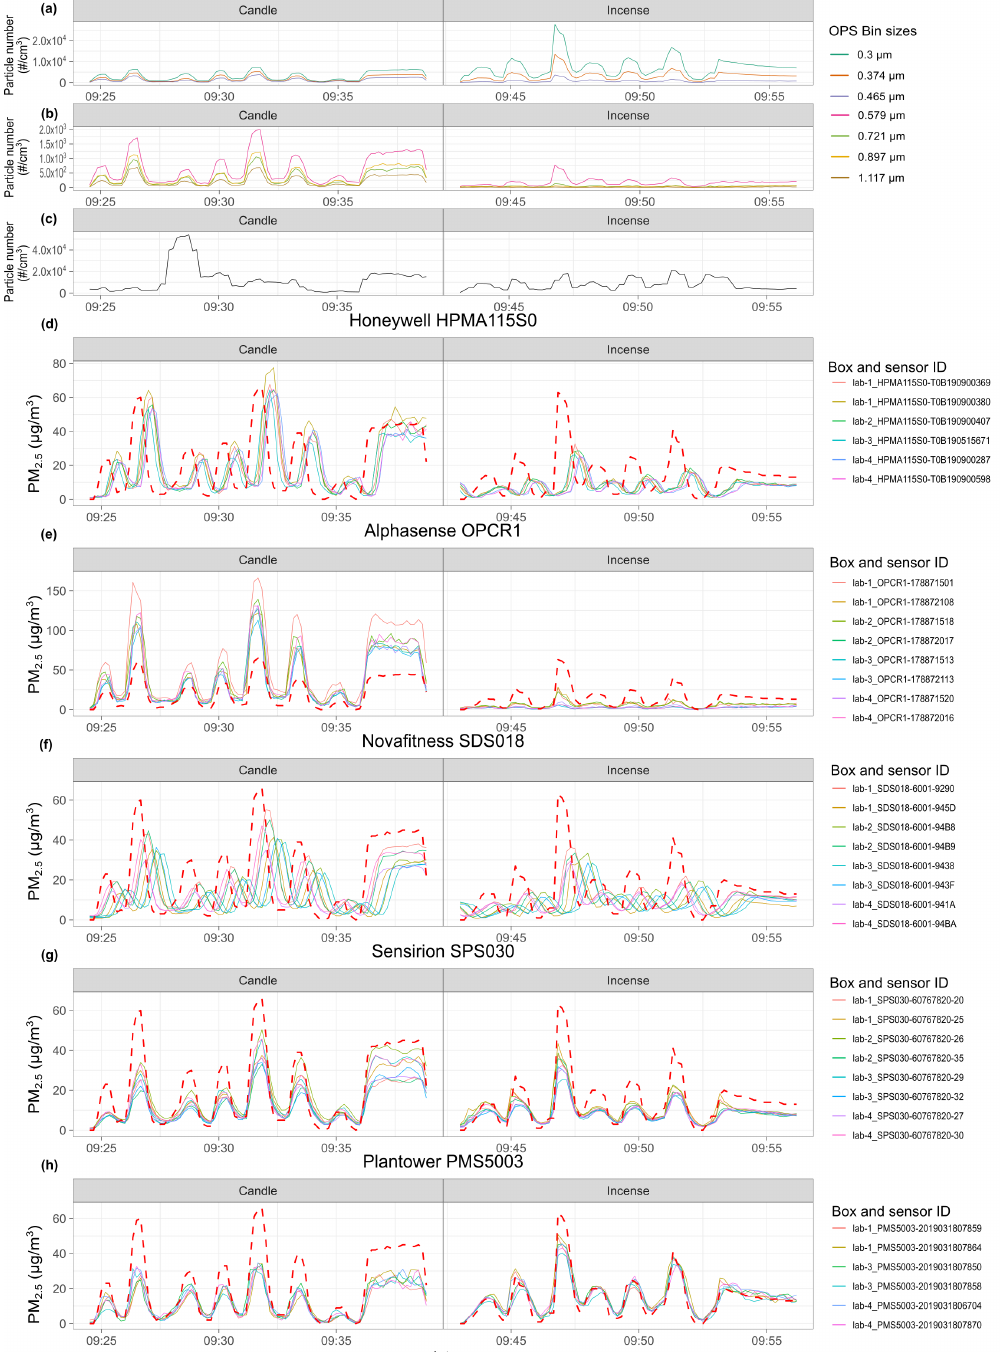
Figure A10. Time series of experiment 2. From top to bottom: ( a , b ) TSI 3330 OPS Bin size distribution; ( c ) Nanotracer ultrafine particles number concentration #1/cm 3 ; ( d – h ) PM 2.5 of the sensors for each model of sensor, against DustTrak (red dotted line). The sensors are named according to the box they are placed in and their serial